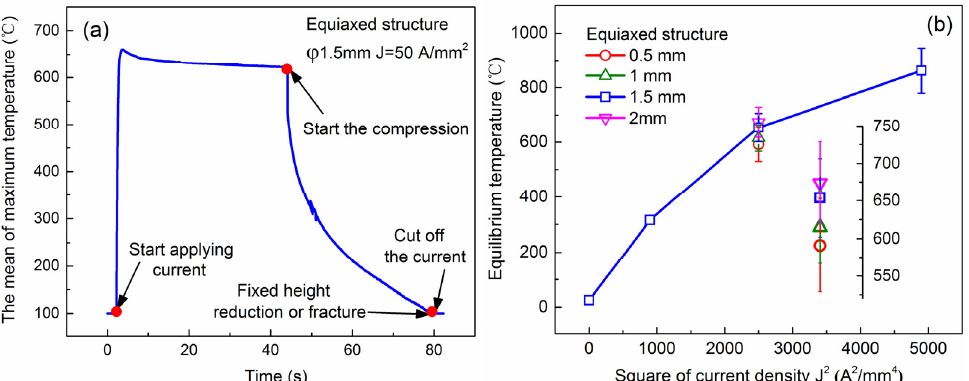
Figure 3. ( a ) The mean of maximum temperature history of equiaxed microstructure specimen with 1.5 mm in diameter under 50 A/mm 2 and ( b ) the relationship between the equilibrium temperature and square of current density of equiaxed microstructure specimen with different specimen sizes.